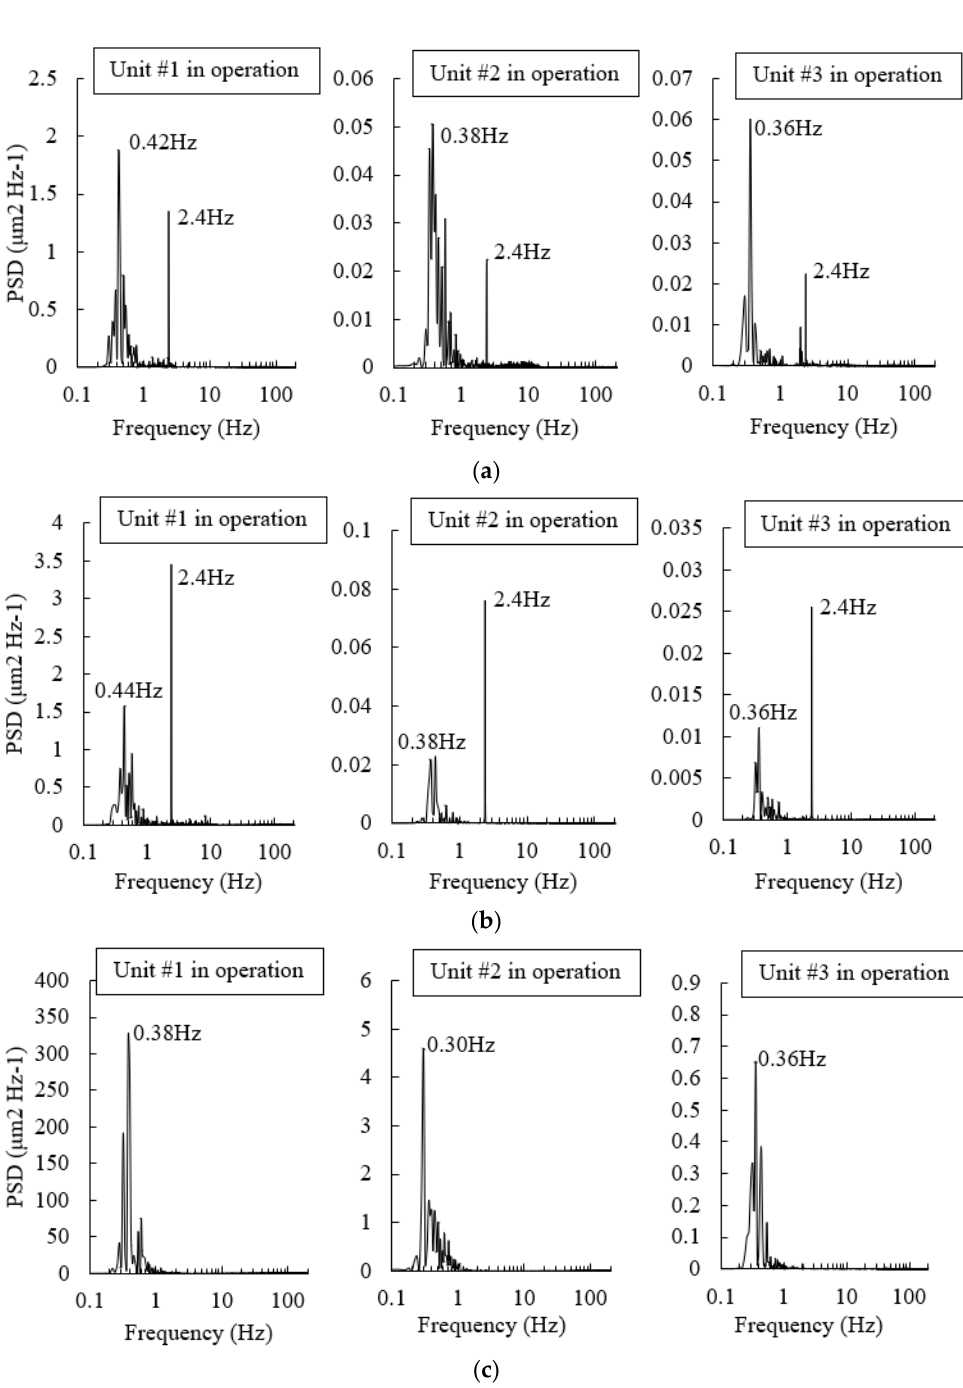
Figure 11. Spectrums of vibration displacements in three directions: ( a ) X direction; ( b ) Y direction; and, ( c ) Z direction.